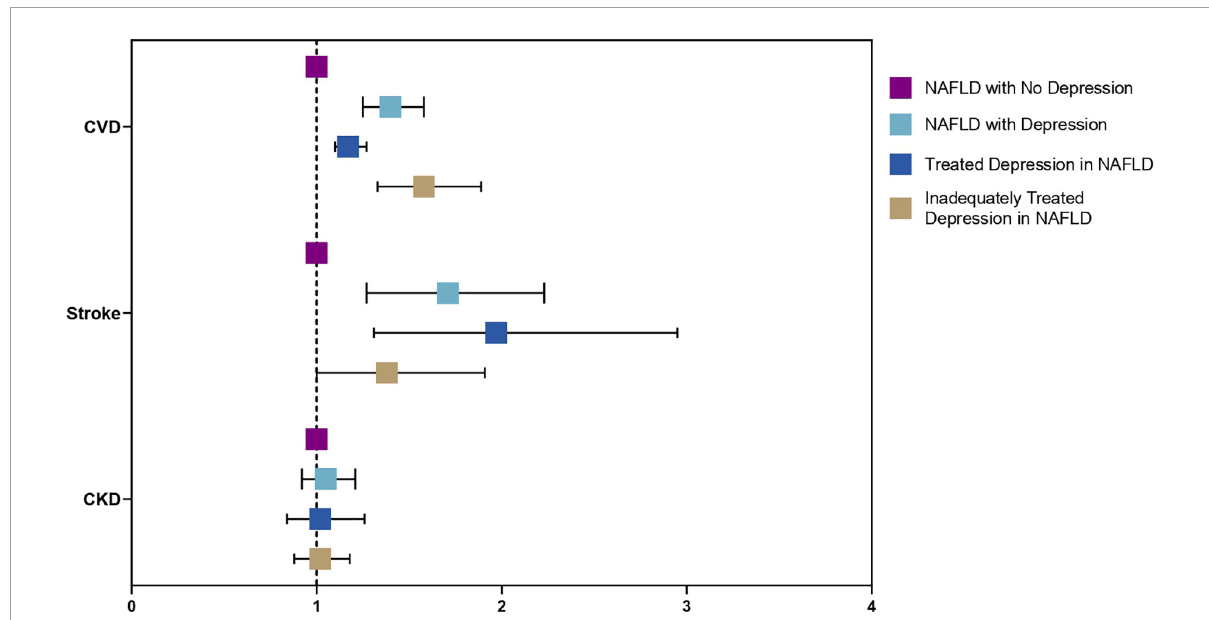
FIGURE4 Forest plots of adverse outcomes in NAFLD with depression, without depression, treated, and untreated depression.